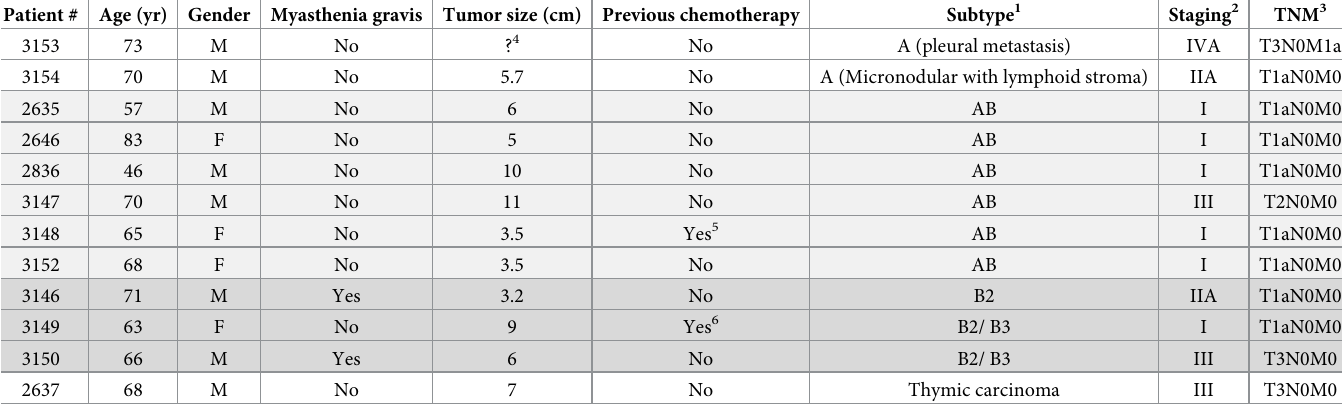
Table 1. Clinical features of thymomas included in the